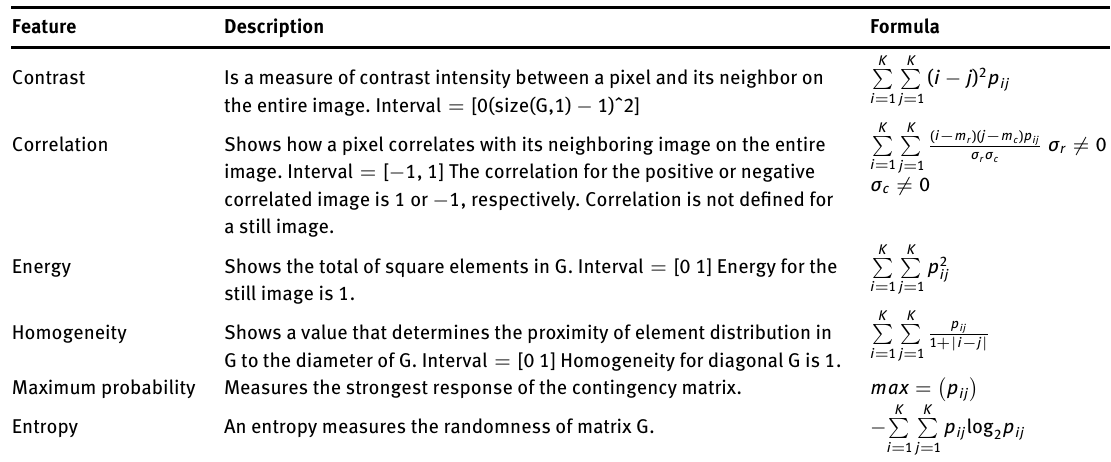
Table 2: Characteristics of Contingency